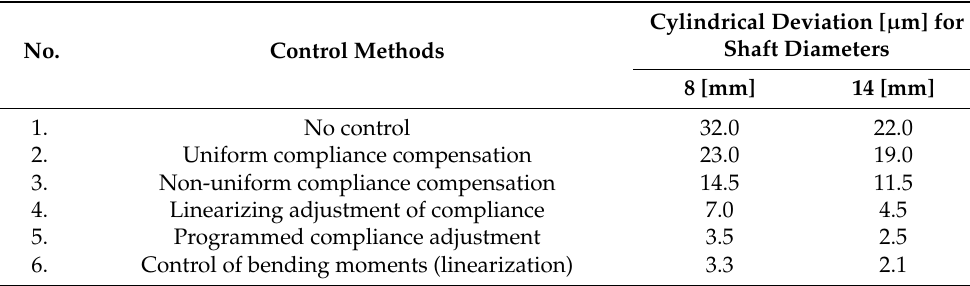
Table 3. Experimental values of maximum shape deviations (cylindricality) of low-stiffness shafts machined using different control